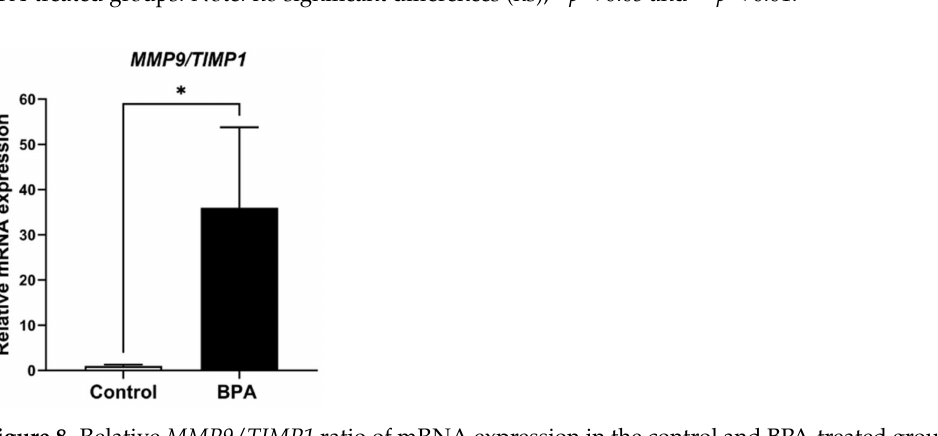
Figure 8. Relative MMP9 / TIMP1 ratio of mRNA expression in the control and BPA-treated groups. Note: * p <